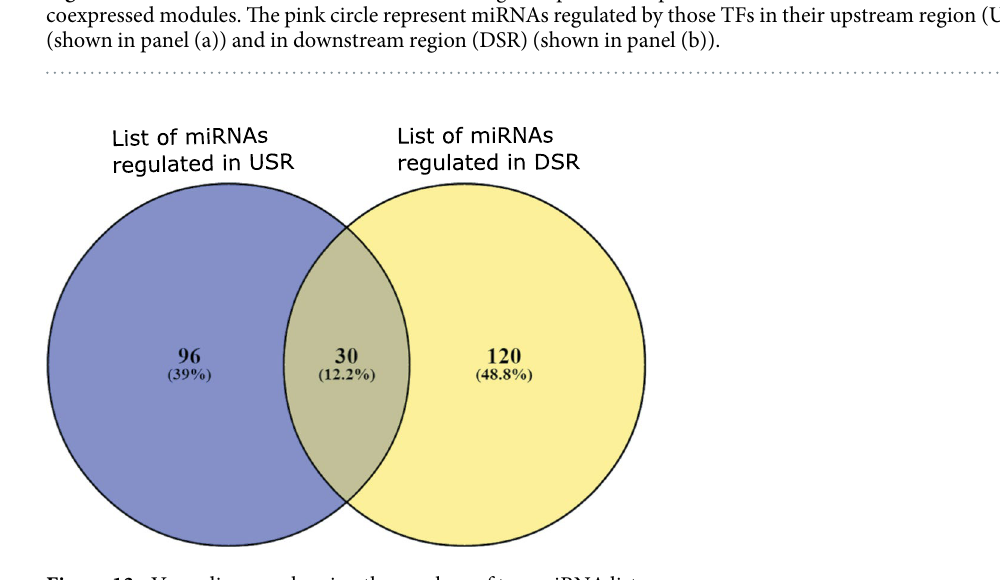
Figure 13. Venn diagram showing the overlaps of two miRNA